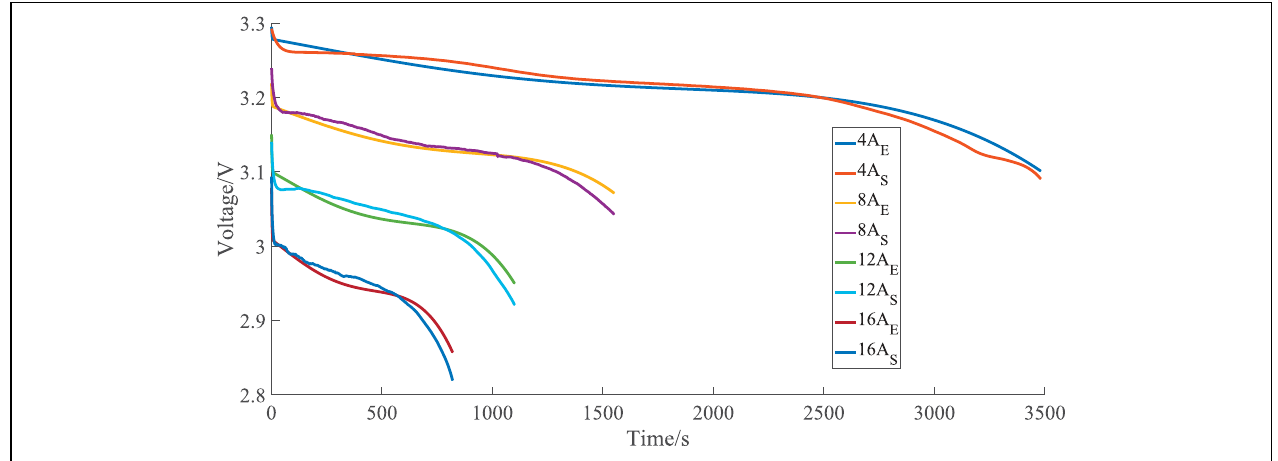
FIGURE 6 | Experimental and estimated OCV data comparison under different